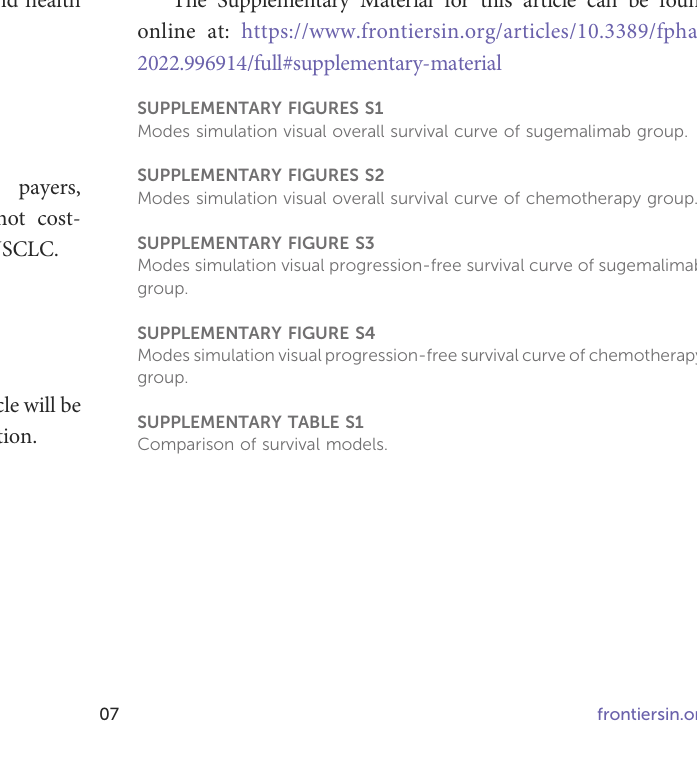
SUPPLEMENTARY FIGURE S3 Modes simulation visual progression-free survival curve of sugemalimab group.